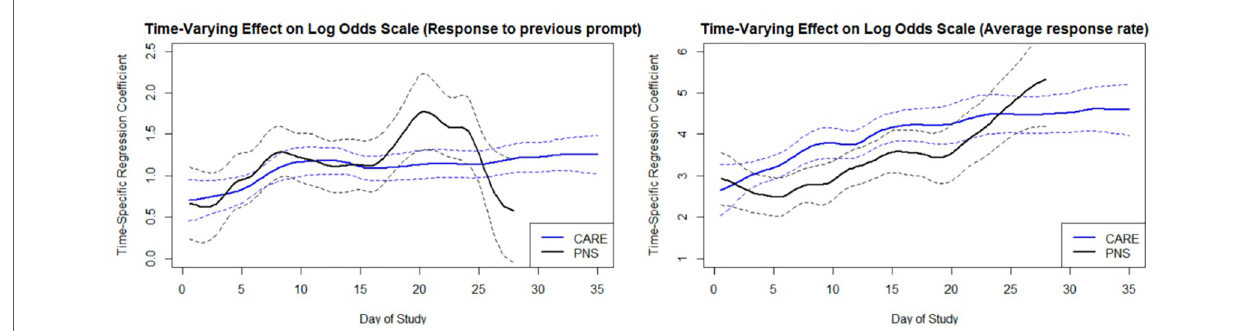
FIGURE 5 TVEM predicting response to current prompt from response to previous prompt (left) and from the average prompt response rate prior to current prompt (right). The coef fi cients show the time-varying relationship strength (as time-varying log odds) between response to current prompt and each of the two candidate